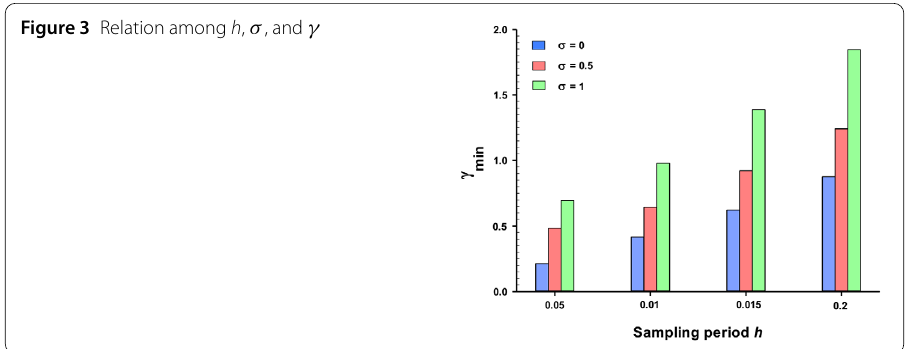
Figure 3 Relation among h , σ , and γ